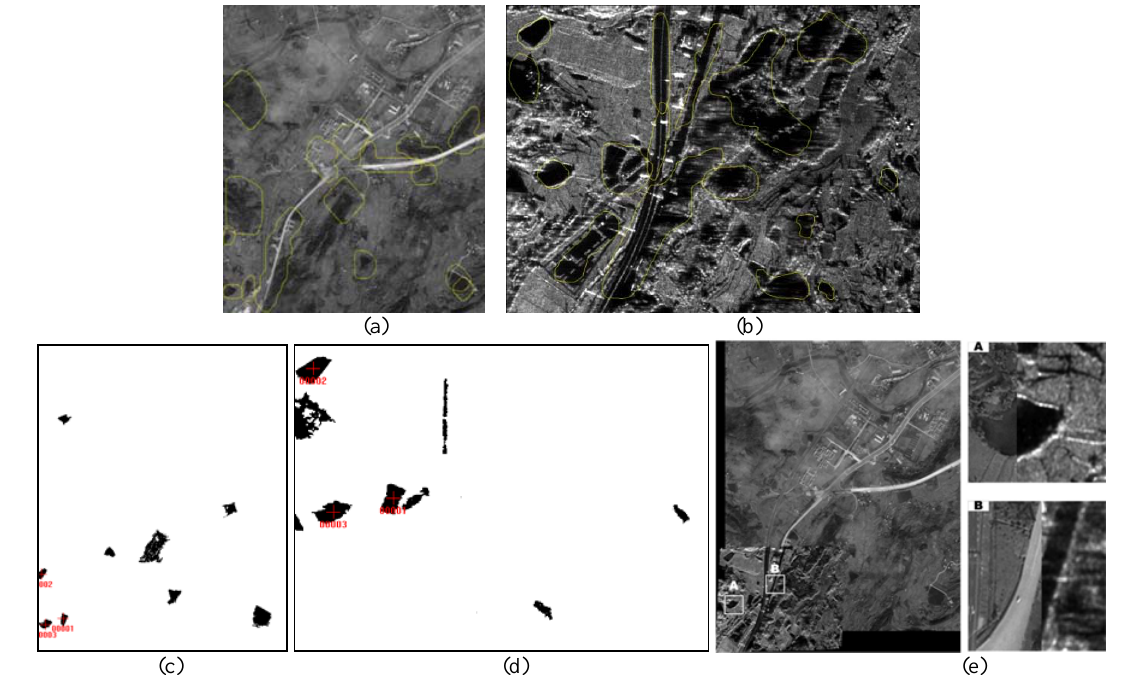
Figure 3. Coarse registration result with visual saliency feature for sequential SAR image 1. (a) Visual saliency region obtained using Itti model for optical image. (b) Visual saliency region obtained using TW-Itti model for SAR image. (c) Set of tie points for optical image. (d) Set of tie points for SAR image. (e) The chessboard overlay result of coarse